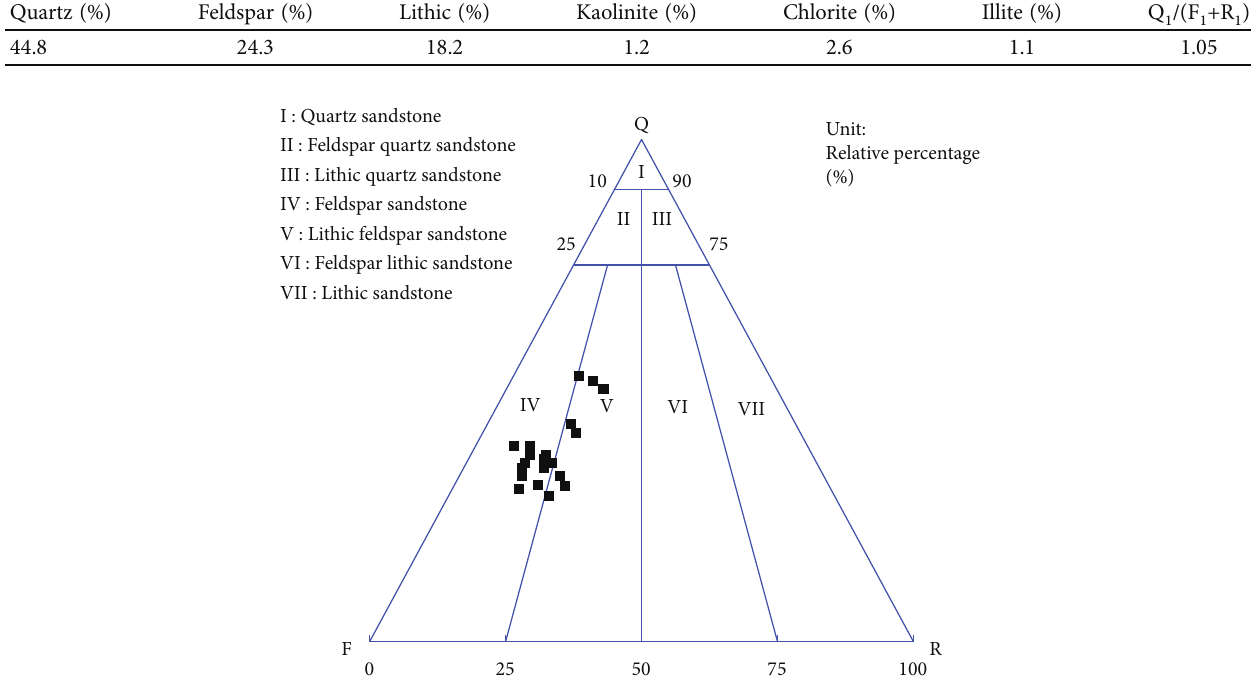
sublayer of Yanchang Formation. 3